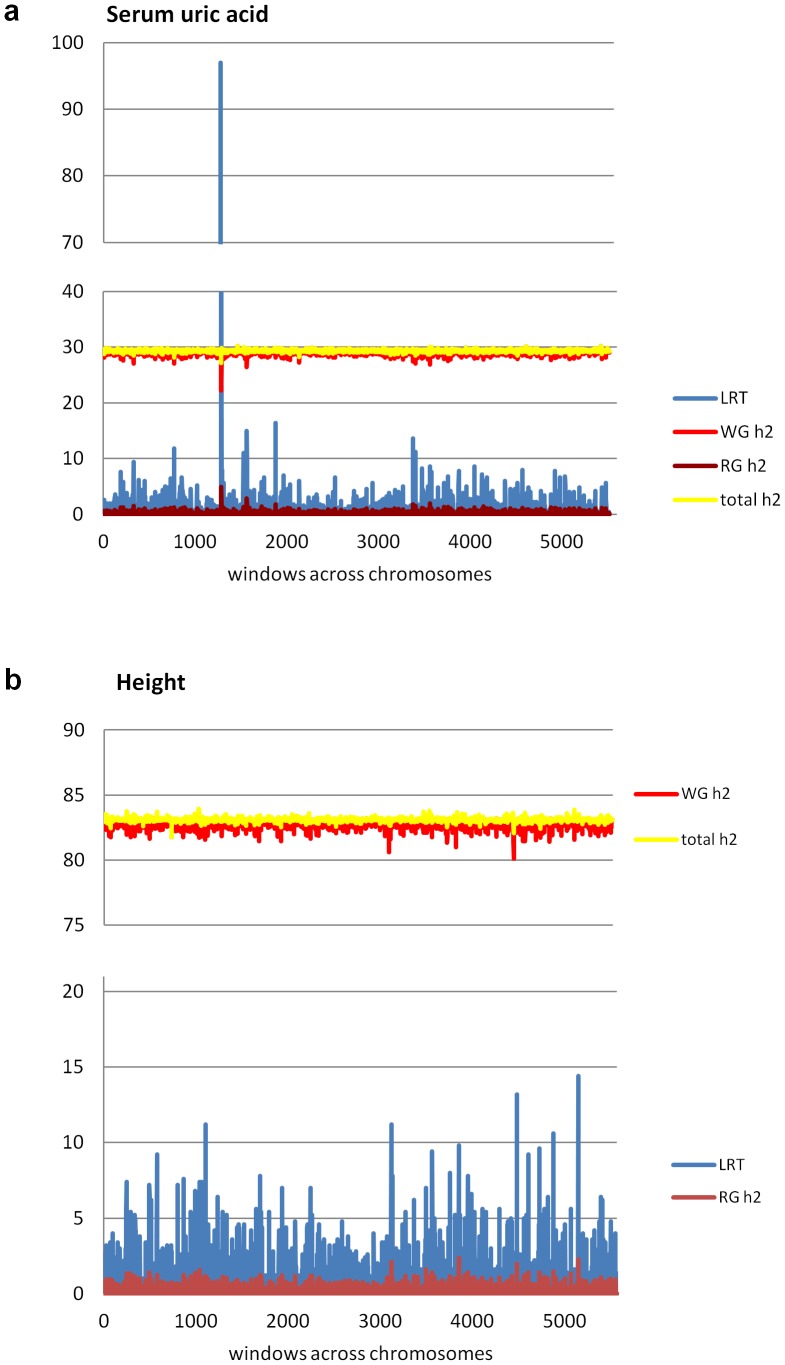
Results from genome-wide analyses of two traits.Plots show the likelihood ratio test (LRT) and regional, genomic and total heritabilities across the genome from analyses of data from Croatian and Italian populations: a) serum uric acid concentration and b) height. Vertical axis is the LRT and heritability (%) and horizontal axis is window number across the genome. RG h2, WG h2 and total h2 are regional heritability, residual whole genome heritability and total (sum of genomic and regional) heritability, respectively.